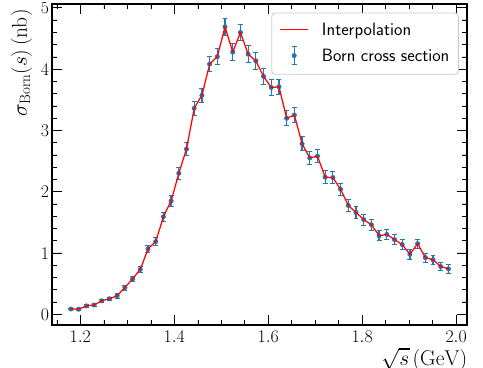
(a) Model Born, model visible and generated visible cross sections.